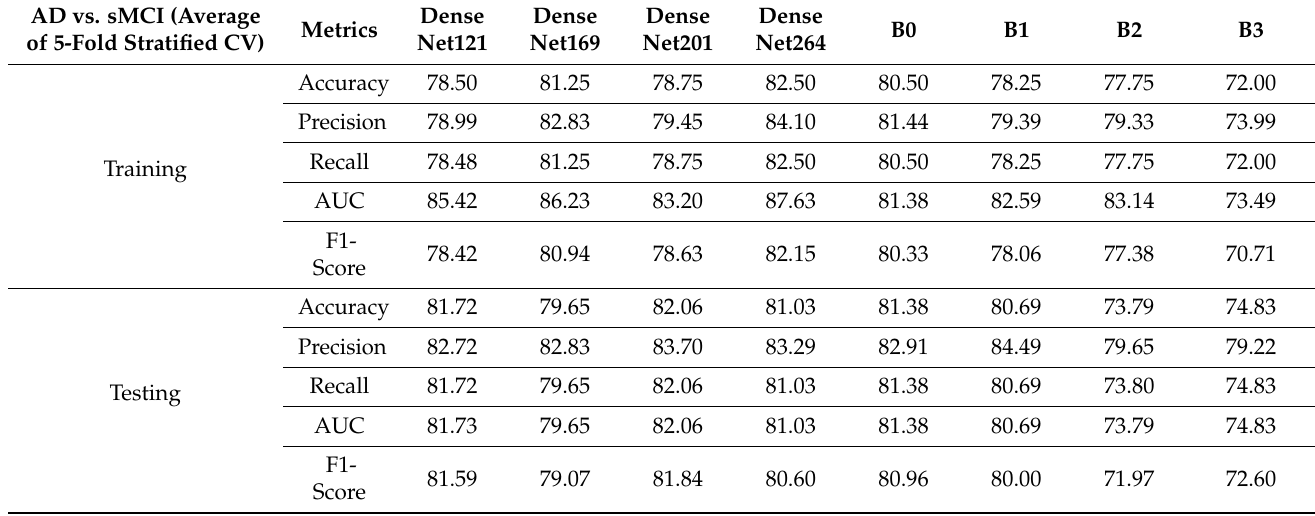
Table 9. The findings of the implemented models for AD vs. sMCI